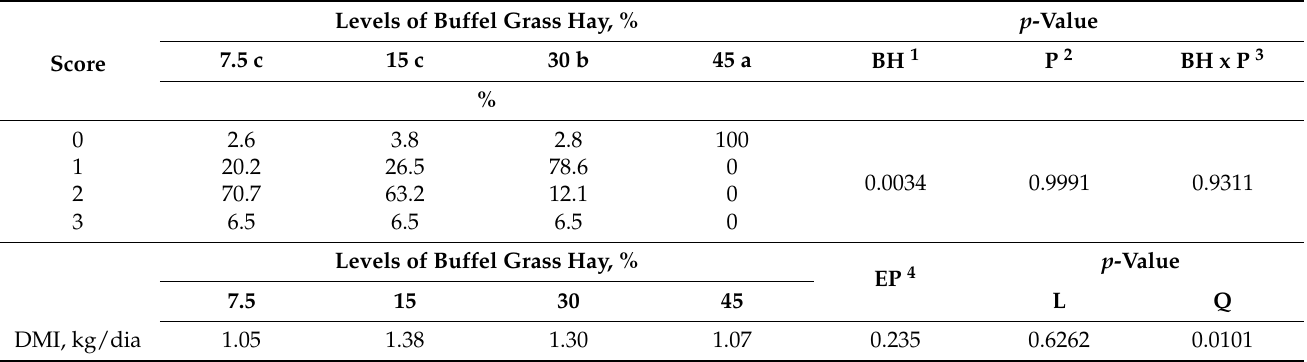
Table 4. Dry matter intake (DMI) and probabilities of occurrence of fecal scores of sheep fed levels of buffel grass hay and cactus